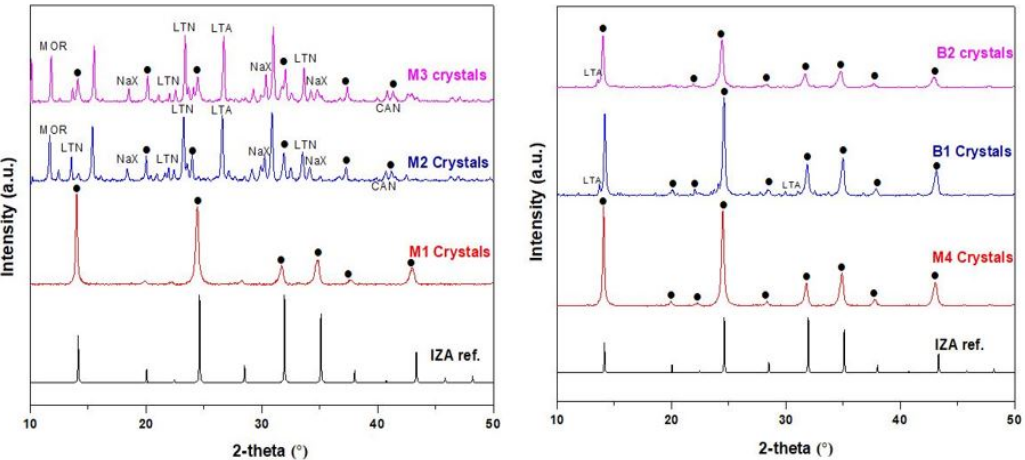
Figure 4. XRD patterns of the crystals obtained from the bottom of the autoclave during the synthesis of membranes M1, M2, M3, M4, B1, and B2. [(•) represents sodalite peak].